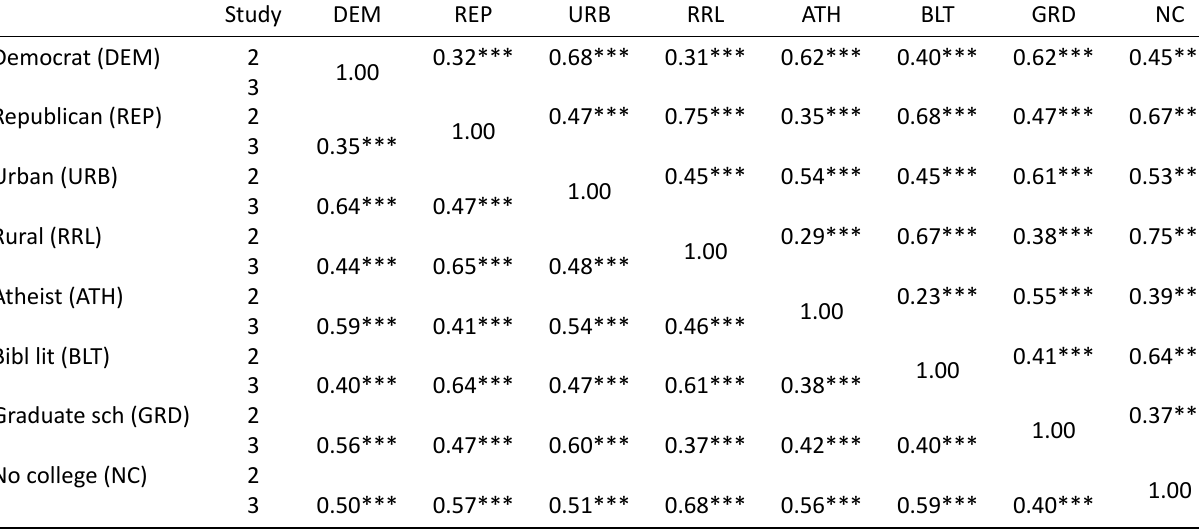
Table 6. Pearson correlations among TPP scores for study 2 and study